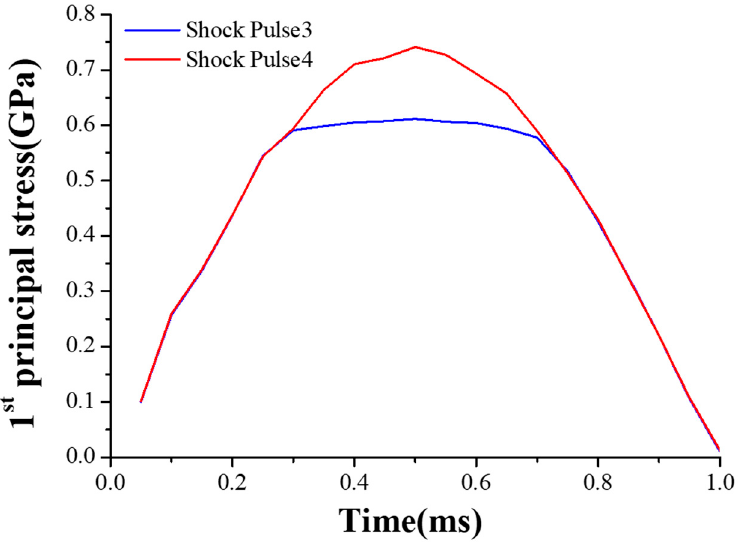
Figure 7. First principal stress of the MEMS tuning fork gyroscope under two Z-axis shock pulses with shock pulse duration of 80 µs.